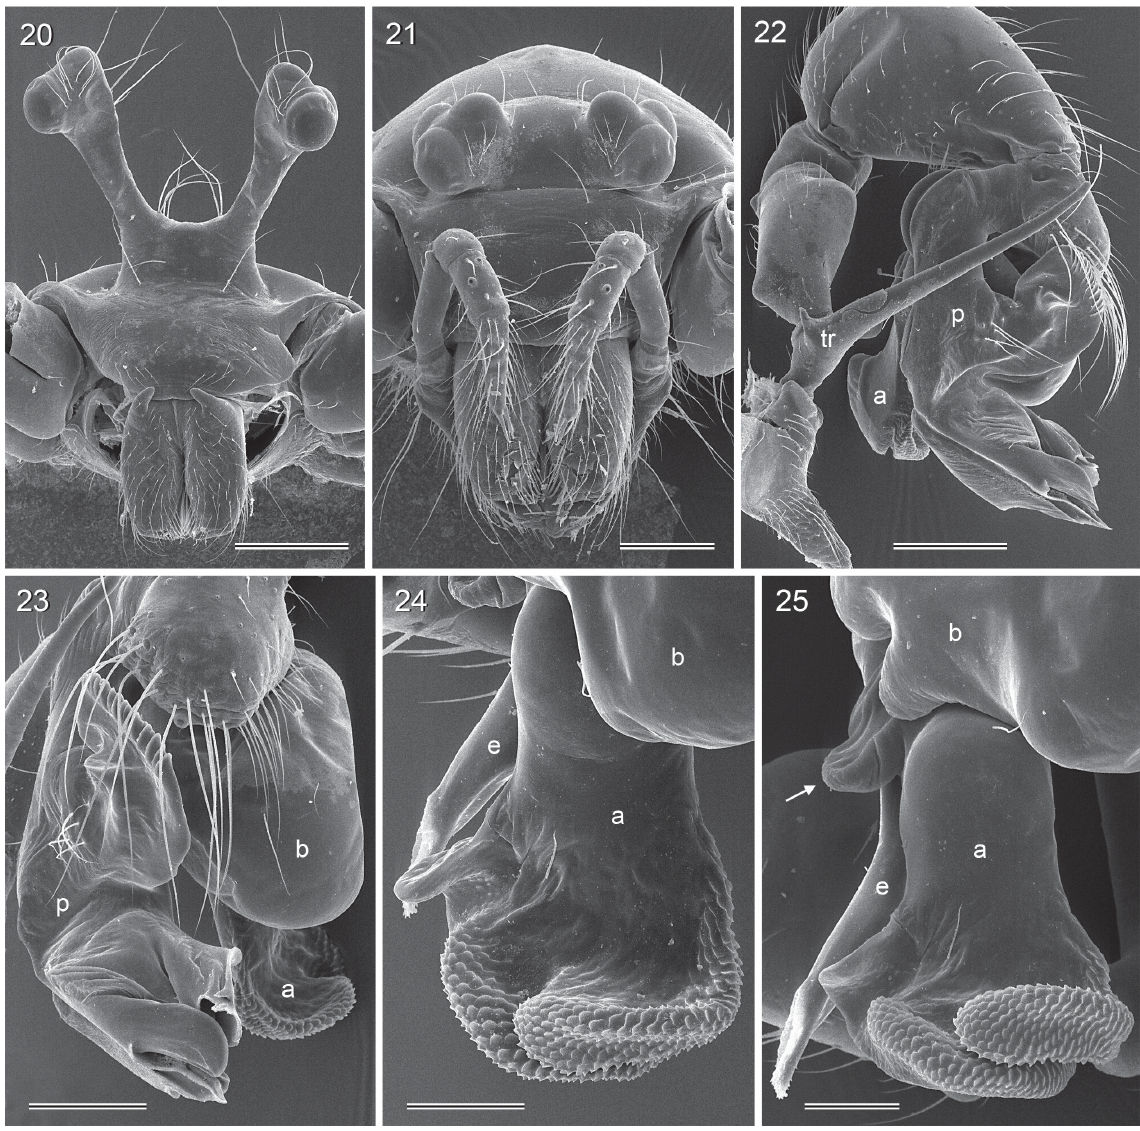
Figs 20–25. Pholcus uludong Huber sp. nov., SeM micrographs (ZFMK, Ar 15695–96). 20–21 . Male and female prosomata, frontal views. 22 . right male palp, retrolateral view. 23 . right procursus and bulb, dorsal view. 24–25 . Left bulb with appendix and embolus, prolateral and prolatero-dorsal views; arrow points at uncus-like process of proximal bulbal sclerite. Scale bars: 20, 22 = 300 µm; 21, 23 = 200 µm; 24–25 = 100